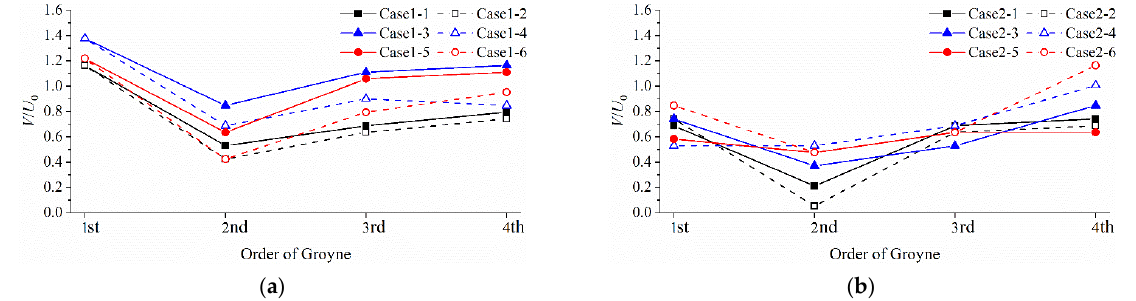
Figure 4. Streamwise velocity at the head of the four groins: ( a ) Velocity at the head of groin (fixed bed) and ( b ) Velocity at the head of groin (mobile bed).